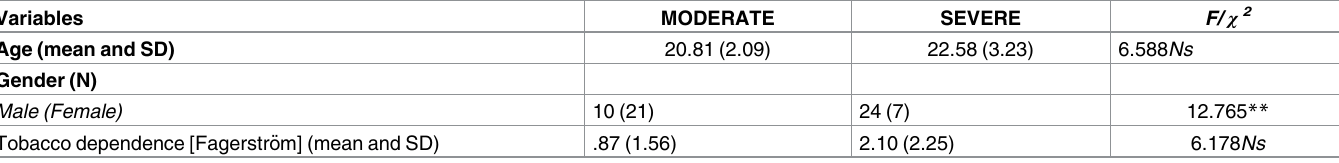
Table 1. Baseline demographic and variables related to cannabis smoking of the participants classified in each of these categories (moderate ver- sus severe).